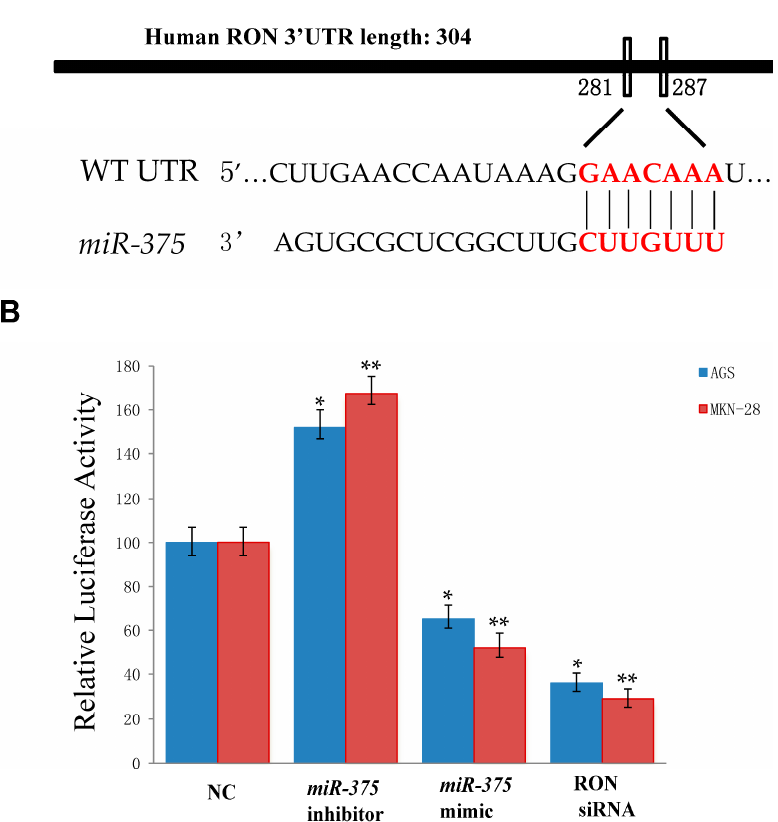
Figure 1. Recepteur d’Origine Nantais (RON) is a miR-375 target. ( A ) Schematic representation of the miR-375 -binding sites in the RON Recepteur d’Origine Nantais (3 ′ -UTR) region, as detected by TargetScan; The letters in red color indicates the corresponding potential targets sites of miR-375 in 3 ′ -UTR of RON; ( B ) Luciferase assay in AGS and MKN cells. AGS and MKN-28 cells were co-transfected with a miR-375 mimic or negative control or RON siRNA and a vector containing the 3 ′ -UTR of RON cloned downstream of a luciferase gene. Relative repression of the luciferase expression was standardized to the β -gal signal. * p < 0.05 versus negative control (AGS cell); ** p < 0.05 versus negative control (MKN-28 cell); The data represent the mean ± SD from triplicate measurements. NC—negative control.